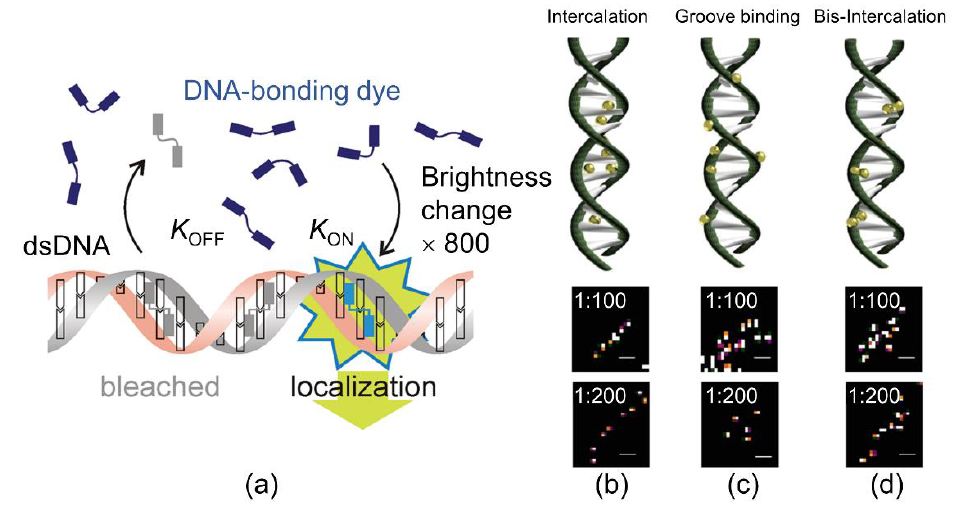
Figure 6. ( a ) Principle of binding-activated localization microscopy (BALM). When the target molecules bind to the free dyes, they turn bright and can be localized until they bleach or separate from the target. k off defines the DNA unbinding rate, and k on defines the DNA-binding kinetics and concentration of the dye in solution. The diagram was reproduced with permission from Schoen et al., published by American Chemical Society, 2011 [31]. Various binding approaches of YOYO-1 in the DNA molecule including ( b ) intercalation, ( c ) groove binding, and ( d ) bis-intercalation. (Top) Binding types of YOYO-1 with λ-DNA based on the position in the strands. (Bottom) Specific regions of YOYO-1 in λ-DNA for the 1:100 and 1:200 (dye:DNA bp) ratios, representing each binding mode